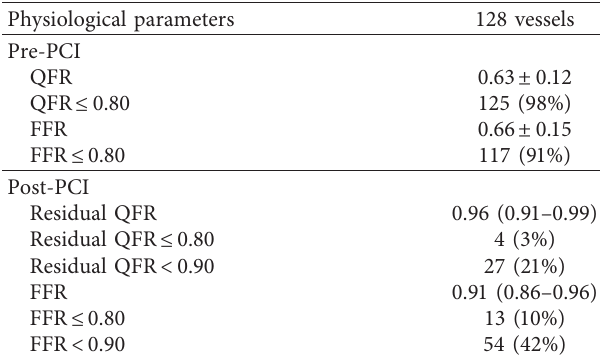
Table 4: Physiological